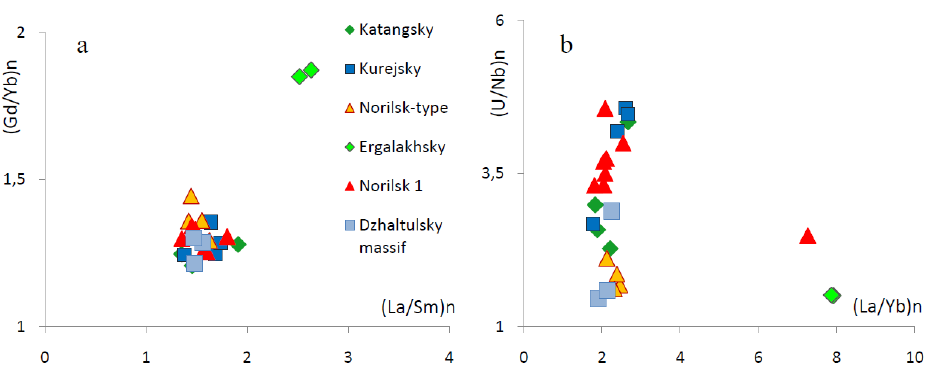
Figure 16. Diagrams (La/Sm)n–(Gd/Yb)n ( a ) and (La/Yb)n–U/Nb)n ( b ) for intrusive rocks.